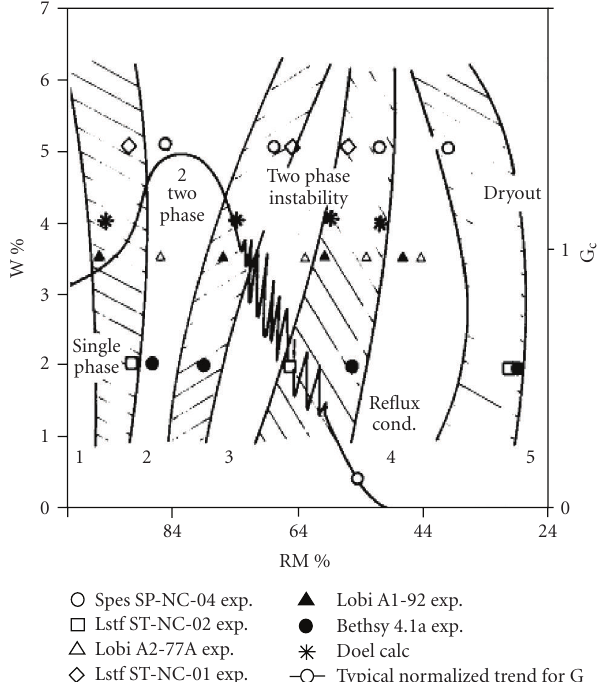
Figure 1: Characterization of natural circulation flow regimes based on experimental data and system code